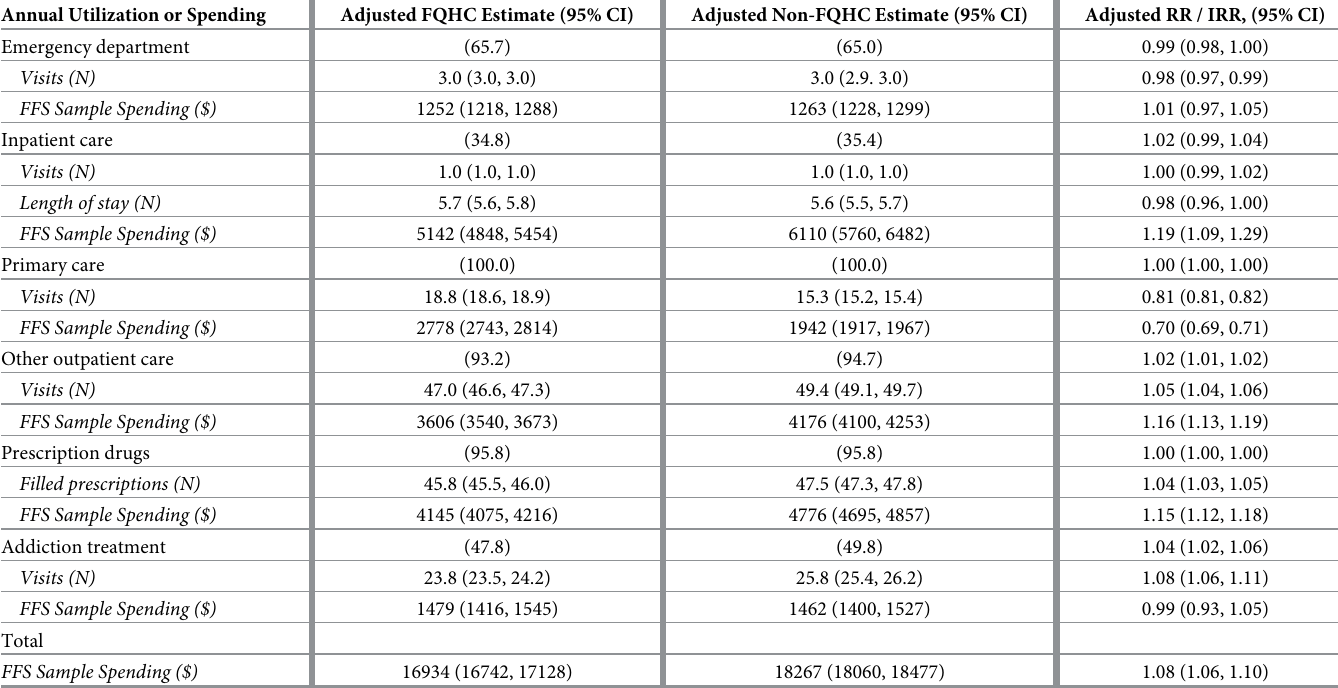
Table 2. Annual use and spending for FQHC OUD patients compared with non-FQHC OUD patients with at least six methods of continuous Medicaid enrollment after OUD diagnosis: United States,